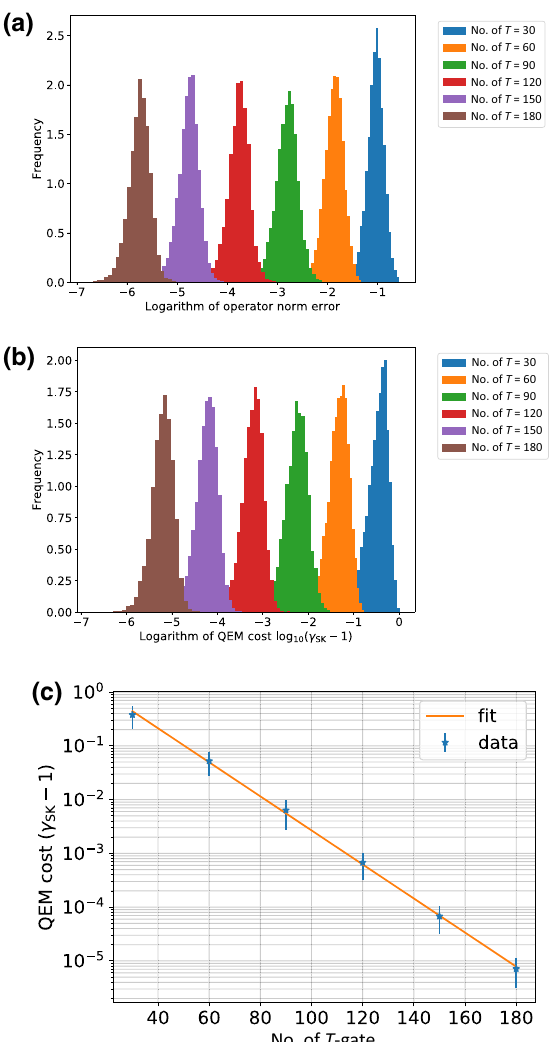
FIG. 6. Approximation error and QEM cost of improved Solovay-Kitaev method calculated for Haar-random unitary operations. Each color corresponds to the maximum count of T gates. (a) Histogram of approximation errors due to the Solovay- Kitaev decomposition. (b) Histogram of QEM costs. (c) His- togram of QEM costs for approximation errors as a function of the number of allowed T gates.